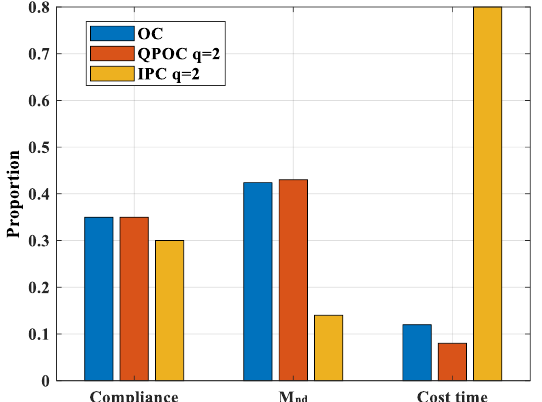
Figure 5. Comparison of optimization indices obtained using different methods.